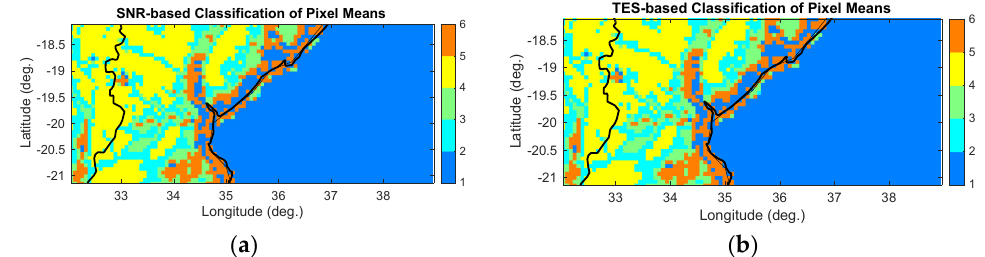
Figure 7. Pixel classification obtained for the area under study using 1 year of data for ( a ) SNR observable and ( b ) TES observable.